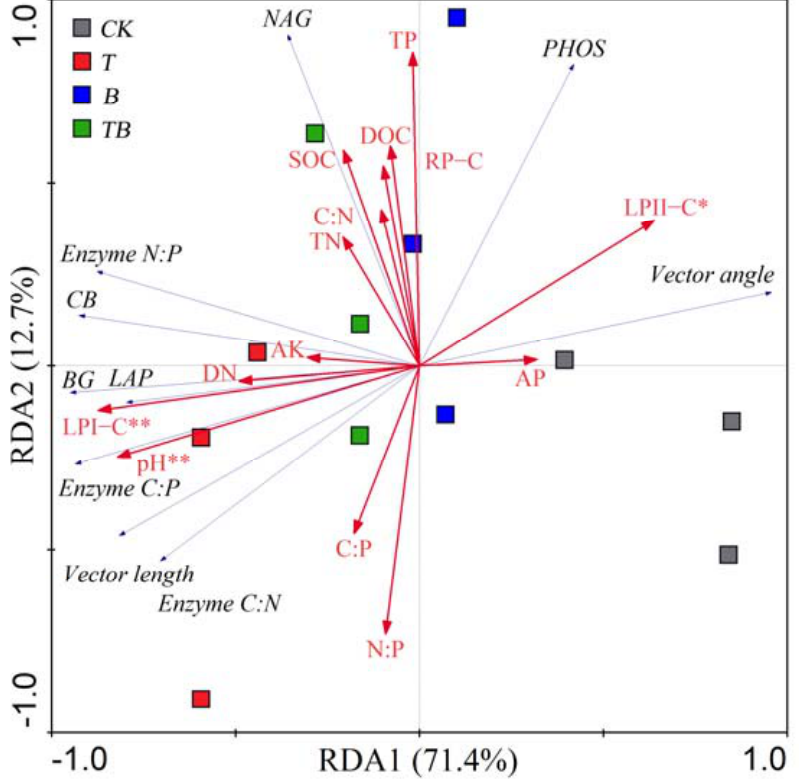
Figure 5. Redundancy analysis (RDA) of soil chemical properties with enzyme activities and their stoichiometry. The red arrows with asterisks indicate significant (*, p < 0.05; **, p < 0.01) factors affecting the enzyme activities and their stoichiometry. Table 2. Results of the permutation test of the redundancy analysis (RDA), estimating potential significant relationships between soil chemical properties with enzyme activities and their stoichi- ometry. The results are based on 999 permutations. Soil Chemical Property